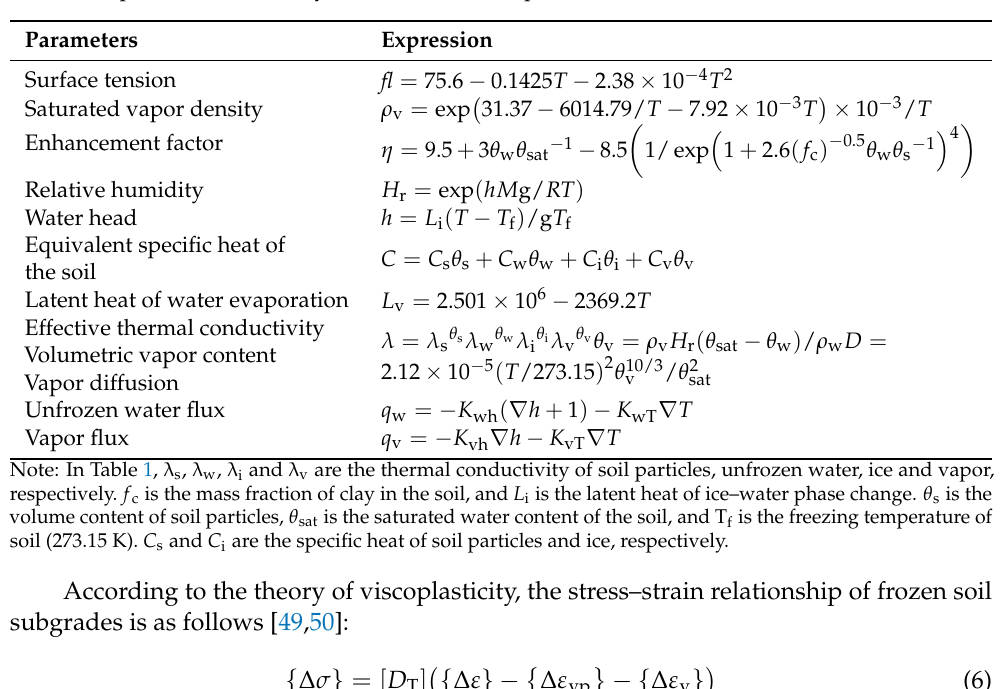
Table 1. Expressions of other hydrothermal–related parameters